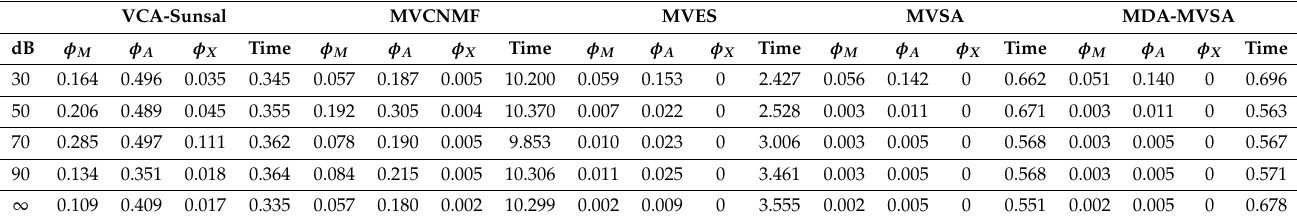
Table 3. Performance and processing time (seconds) for different endmember extraction algorithms on synthetic data with 2000 pixel points and five endmembers and containing nonpure mineral signatures (maximum purity of 0.8) for the USGS library under different noise